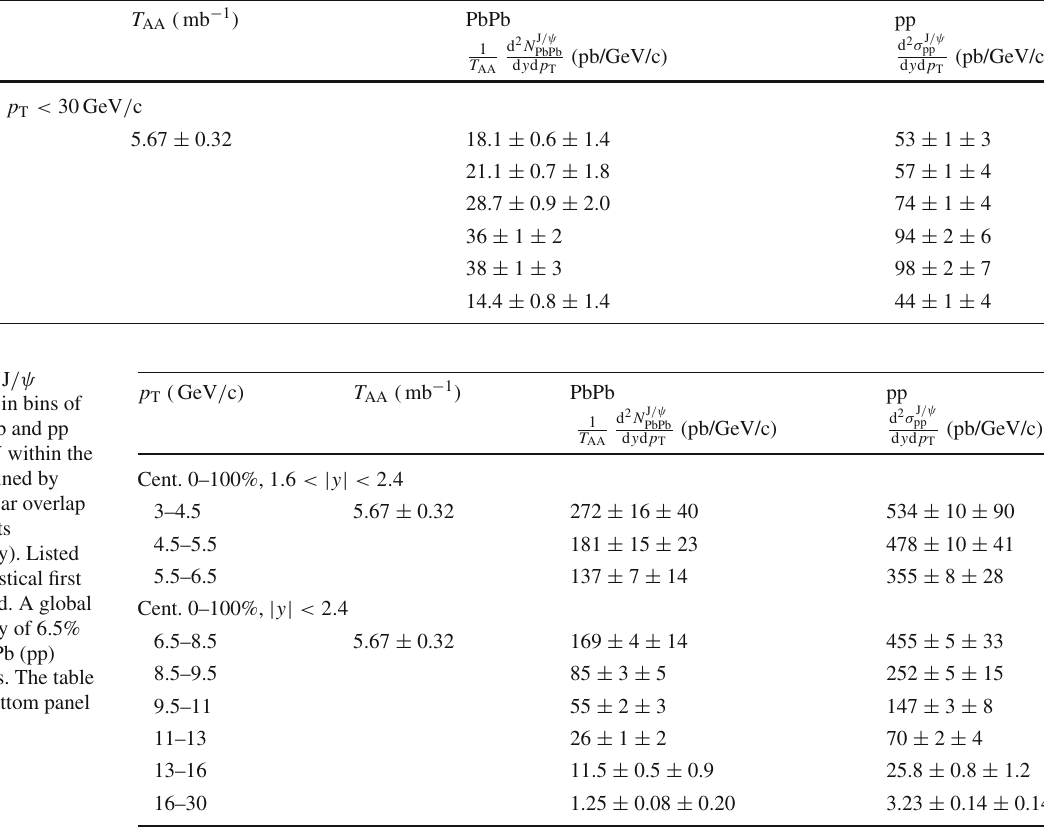
Table2 ThepromptJ /ψ fiducialcrosssectioninbinsofabsoluterapid- ity, measured in PbPb and pp collisions at 2.76TeV within the muon acceptance defined by Eq. (4), and the nuclear overlap function ( T AA , with its systematic uncertainty). Listed uncertainties are statistical first